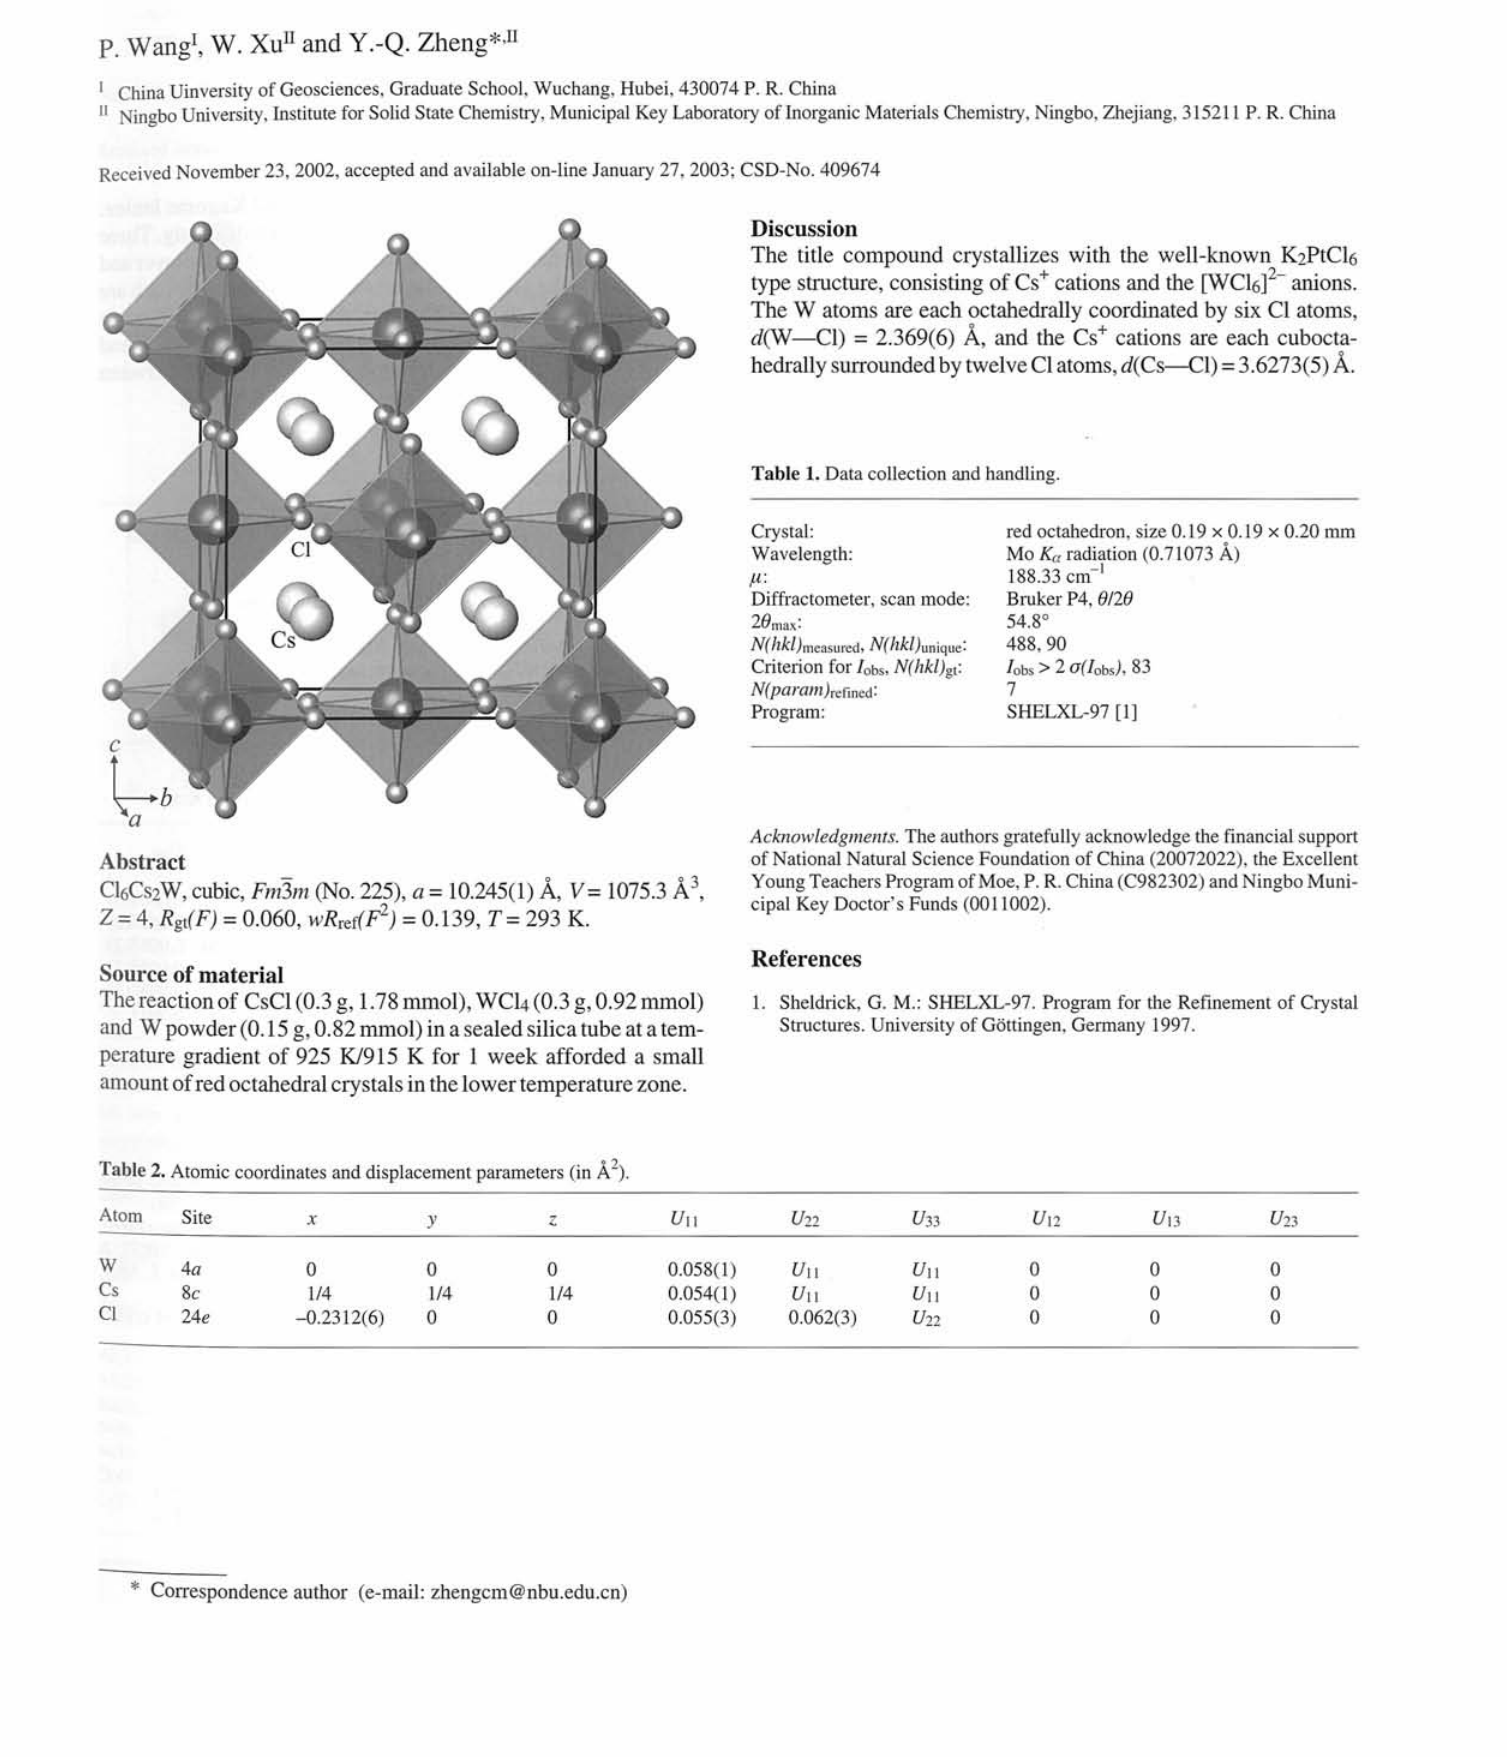
The title compound crystallizes with the well-known KiPtClô type structure, consisting of Cs + cations and the [WCI ô ] 2 anions. The W atoms are each octahedrally coordinated by six CI atoms,